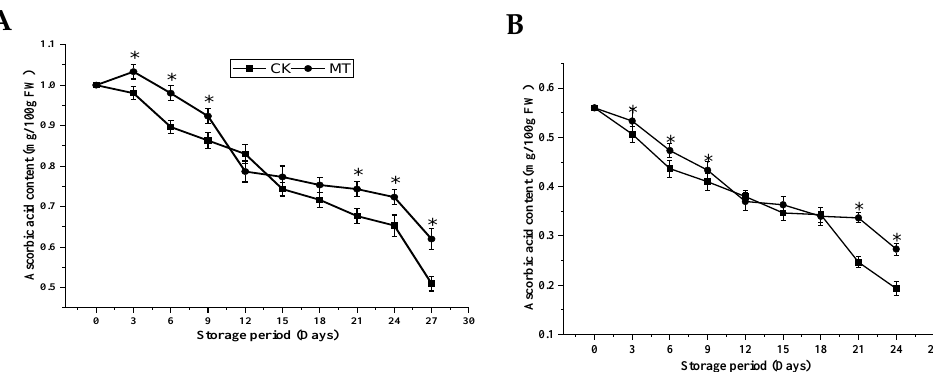
Figure 4. Ascorbic acid content ( A , B ) of ‘Guiqi’ ( A ) and ‘Tainong 1’ ( B ) fruits treated with 1000 μmol L −1 MT. Each value is the mean for three replicates, and vertical bars indicate the standard error (SE). Error bars with an asterisk (*) on the same storage period show a significant difference between the treatments ( p < 0.05).